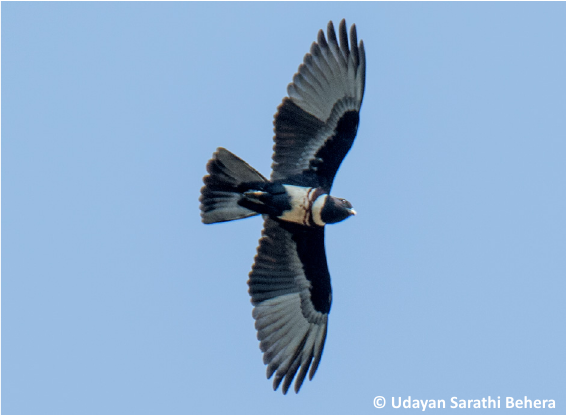
Image 1. The Black Baza soaring over the forests of